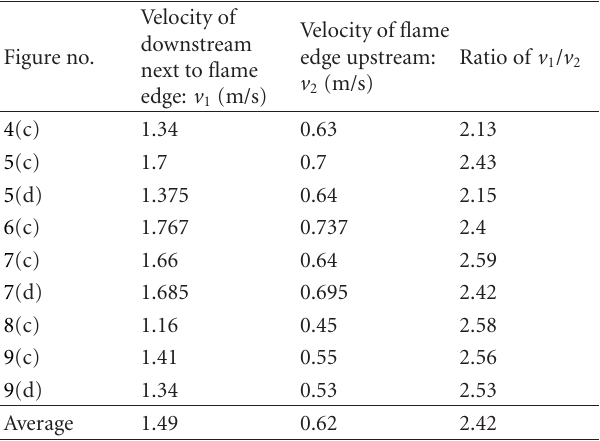
Table 1: Velocity magnitudes and ratios at flame edges. Velocity Figure no.